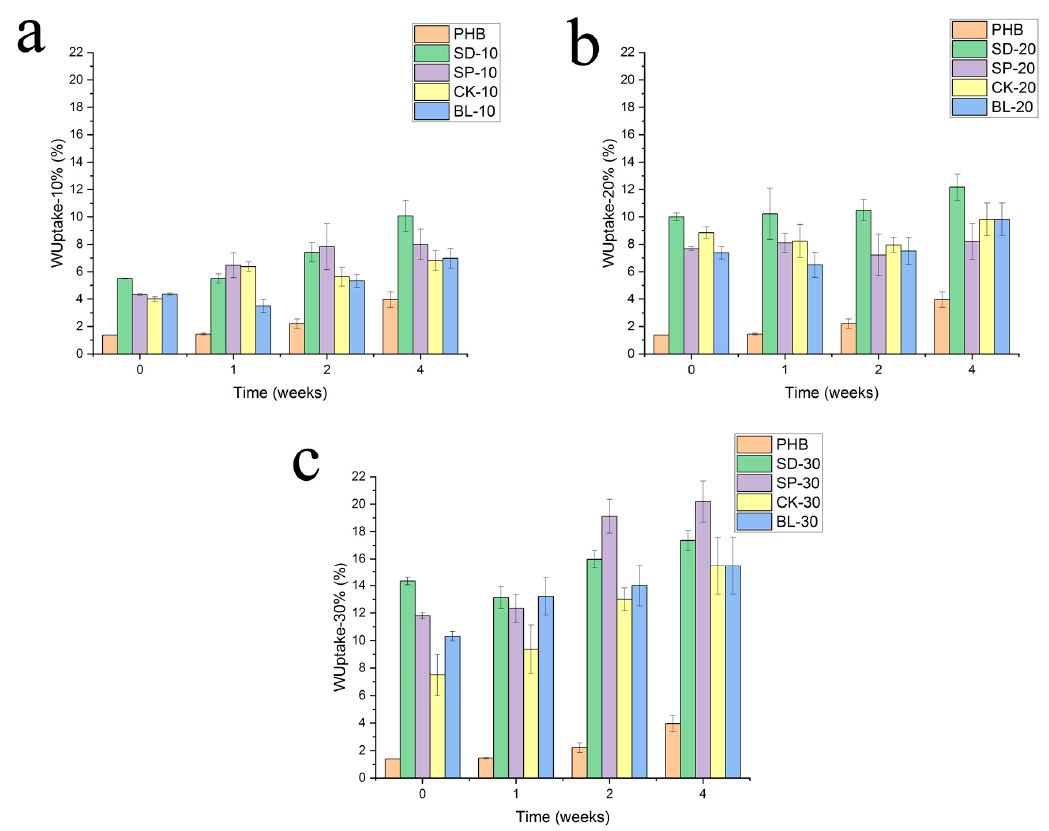
Figure 5. Evolution of the water uptake of composites with the exposure time on Xenotest. Rein ‐ forcement: ( a ) 10%, ( b ) 20% and ( c ) 30%. ment: ( a ) 10%, ( b ) 20% and ( c )